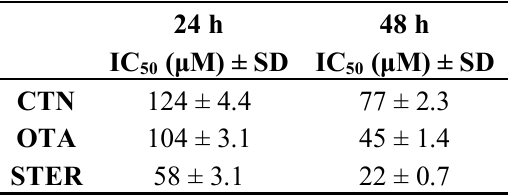
Table 1. Mean values of IC50 in micromolar (μM) ± SD for CTN, OTA, STER as determined by MTT assay, were obtained using non-linear regression of three independent experiments in 8-plicates through the GraphPad Prism 5.91